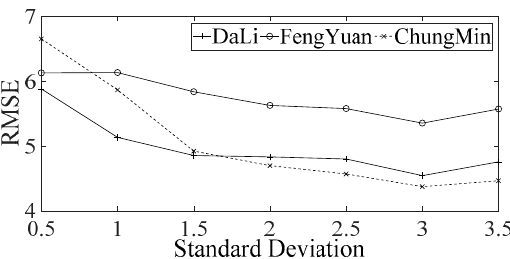
Figure 12. Influence of different abnormal threshold values on RMSE in usual case emphasizing normalization (UCENormalization).